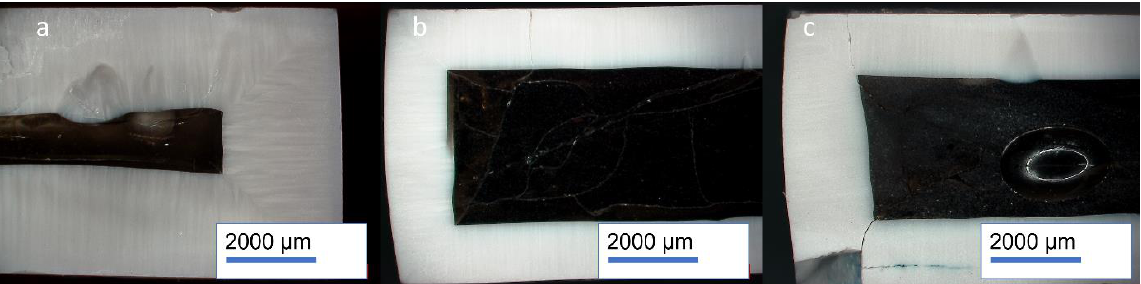
Figure 14. Optical microscope images of samples of parent glass C4 heat-treated at 850 ◦ C for 20 h ( a ), 900 °C for 2 h ( b ) and 950 °C for 0.5 h ( c ). ( a ), 900 ◦ C for 2 h ( b ) and 950 ◦ C for 0.5 h ( c ( a ), 900 °C for 2 h ( b ) and 950 °C for 0.5 h ( c ).